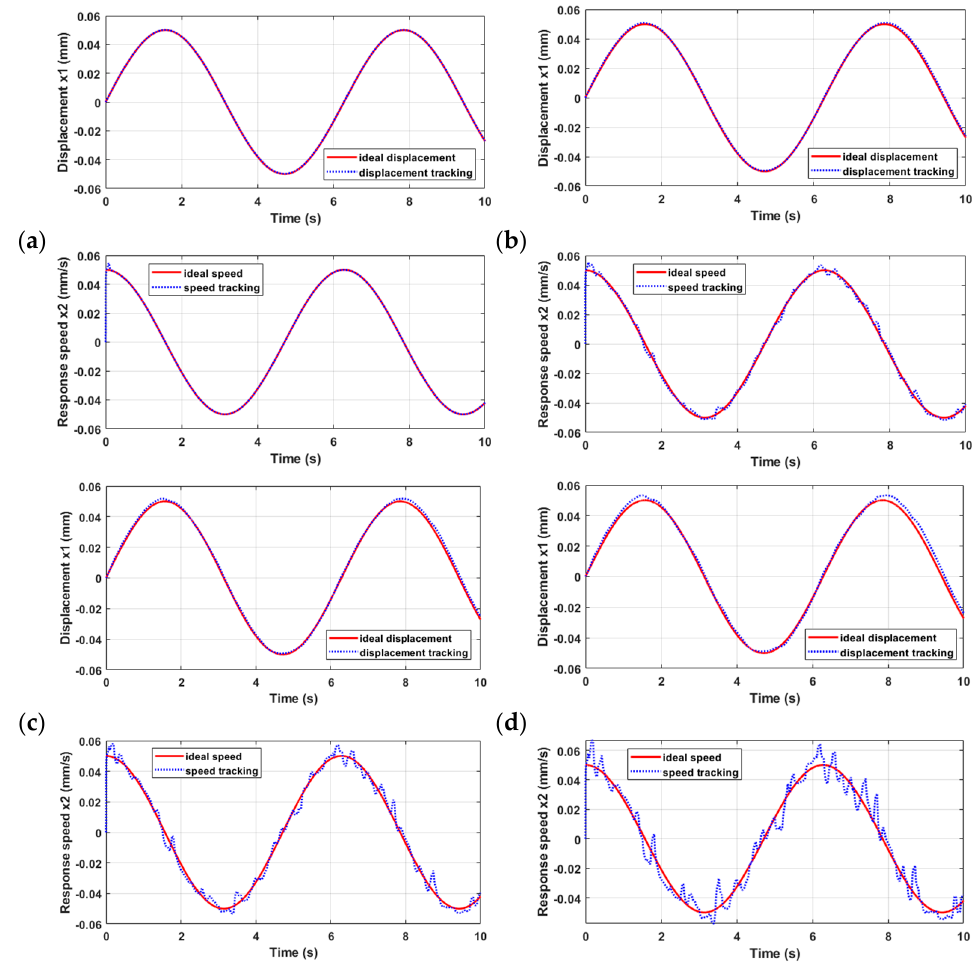
Figure 8. Axial displacement and response speed of the A-HMB system under disturbance of different road roughness grades. ( a ) Non-interference signal. ( b ) A-level road surface. ( c ) B-level road surface. ( d ) C-level road surface.